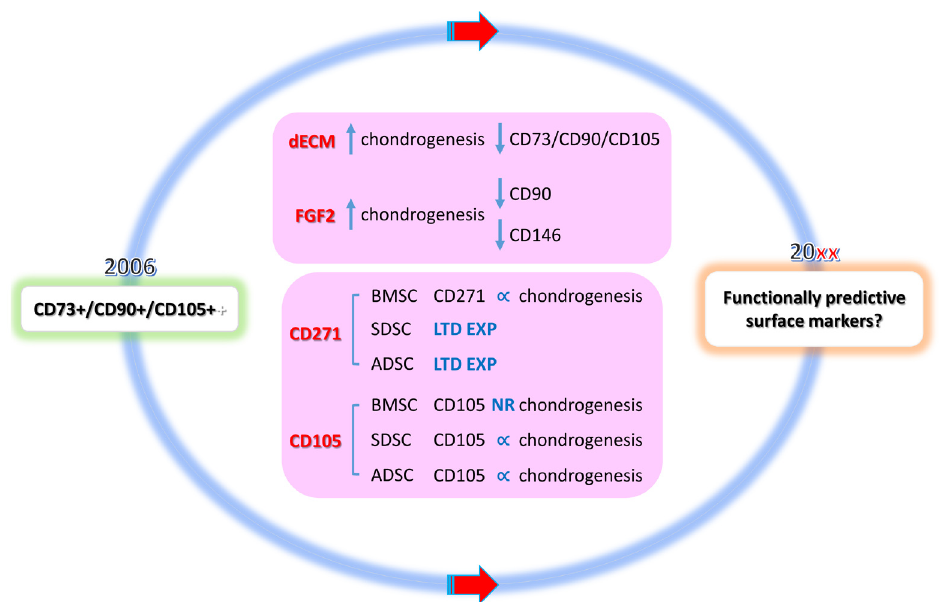
Figure 1. Schematic diagram of our Commentary on ‘Surface markers associated with chondrogenic potential of human mesenchymal stromal/stem cells’. Human mesenchymal stromal/stem cells (MSCs) were defined in 2006 by the International Society for Cellular Therapy. Unfortunately, currently accepted predictive surface markers do not seem to be ideal candidates to predict MSCs with chondrogenic potential in terms of inconsistency of currently accepted surface markers and chondrogenic potential of MSCs and tissue source–dependent MSC surface markers that correlate with chondrogenic potential. Are functionally predictive surface markers the next target for sorting MSCs in cartilage engineering and regeneration? ∝ , positive correlation; ADSC, adipose-derived stromal/stem cell; BMSC, bone marrow-derived stromal/stem cell; dECM, decellularized extracellular matrix; FGF2, fibroblast growth factor 2; LTD EXP, limited expression; NR, not related; SDSC, synovium-derived stromal/stem